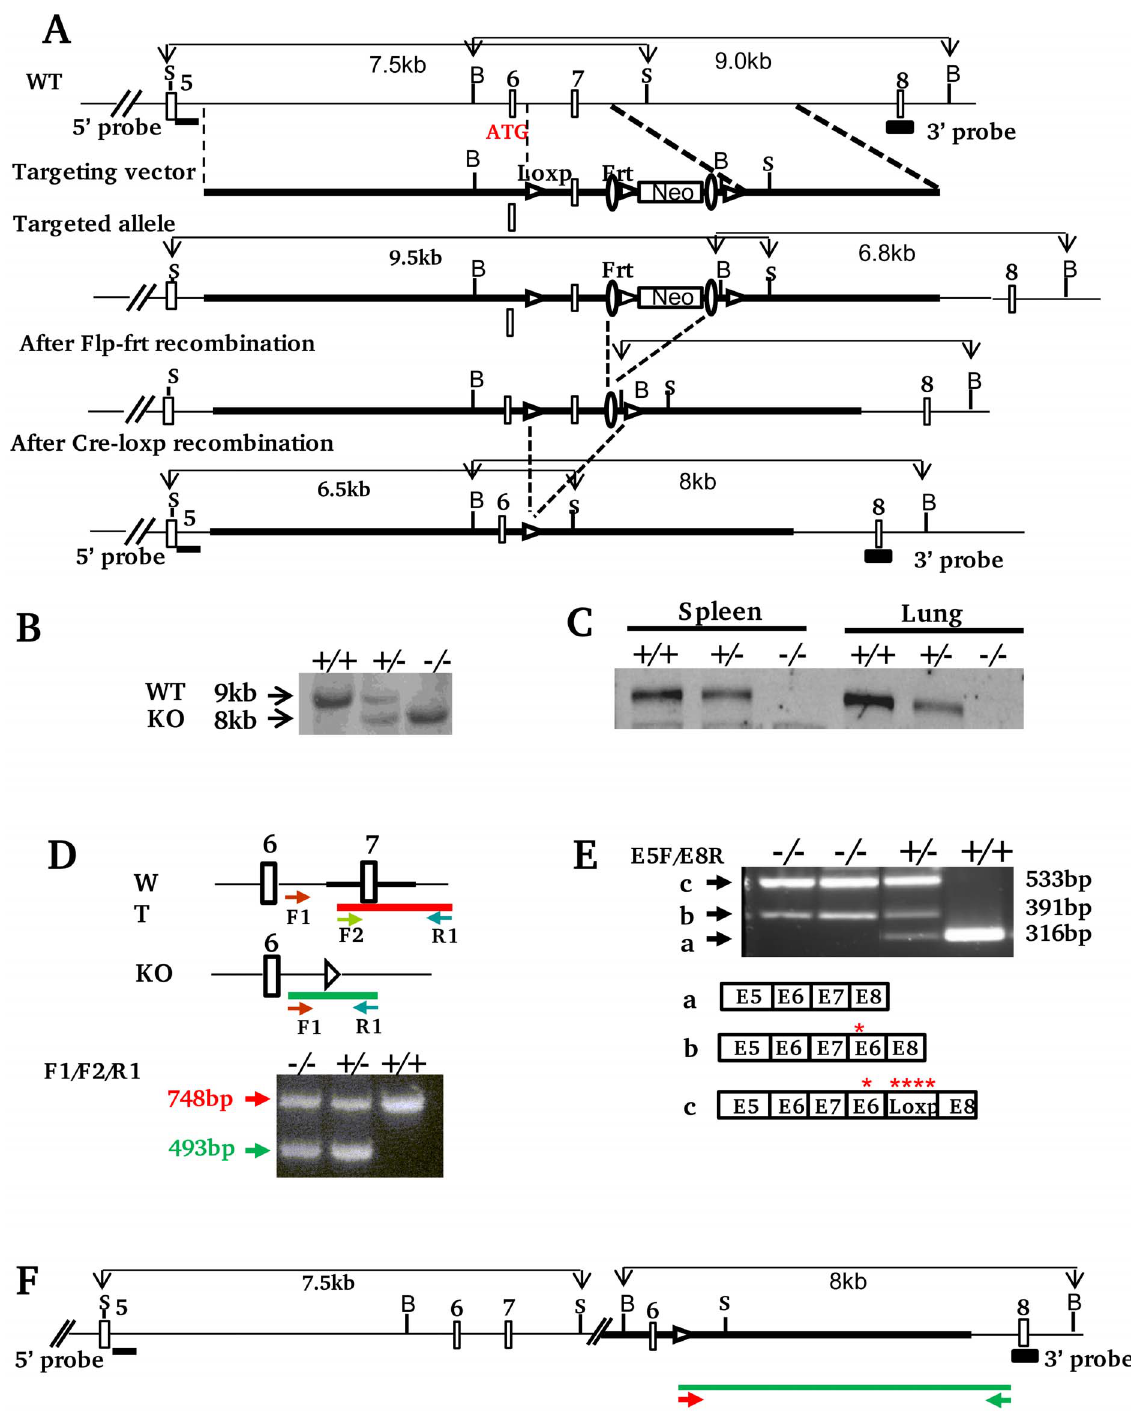
Figure 1. Generation of Xb130 2 / 2 mice. A.Schematicstrategyofxb130genetargeting. Structure of Xb130 gene (5 9 part), targeting construct, targeted allele and final knockout allele are shown (Empty Boxes: exons; S: SacI; B: BamHI, Filled boxes: Sites for Southern blot probes). Homologous recombination of ES cell genomic DNA with targeting construct inserts Loxp and Frt sites flanking an 879 bp region including Exon 7 and a floxed neomycin cassette. The deletion of Exon 7 causes a frame shift mutation and translation termination in Exon 8. B.Southernblottingwith3 9 probe. Mice were derived from Xb130 + / 2 progeny. C.Westernblotting. Protein lysates were extracted from spleen and lung tissues of Xb130 + / + , Xb130 + / 2 and Xb130 2 / 2 mice that were genotyped by Southern blotting. D.PCRbasedgenotyping . Arrows indicate the location of primers used for PCR amplification. PCR product amplified from F1 and R1 in WT allele was undetectable due to competition from short product F2/R1. E.RT-PCR. The exons of RT-PCR products from WT (a) and knockout (b and c) mice are indicated based on sequencing data. Red stars indicate induced in-frame stop codons. F.PredictedXb130knockoutallelebasedonRT-PCRandgenomicPCRdata. The primers used for long PCR and the amplicon are indicated as arrows and green line respectively.